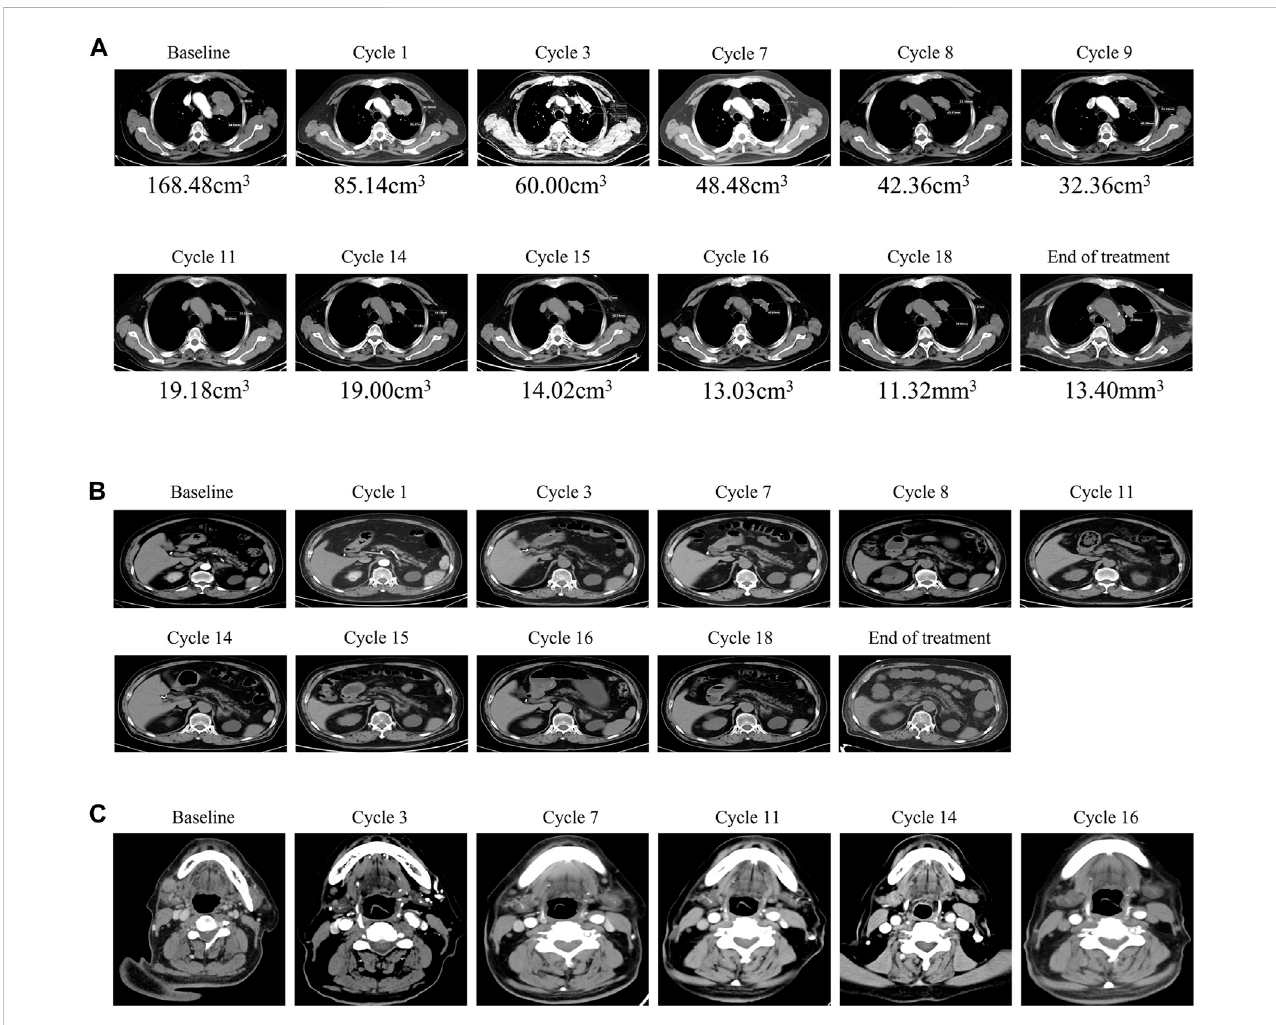
FIGURE 1 Changesinlungtumor andmetastatictumorduring camrelizumabandanlotinibtreatment. (A) CTshowedthat thelungtumorbegantoshrink after fi rst cycle of treatment until the end of treatment. (B) CT showed that the volume of bilateral adrenal invasion lesions was signi fi cantly reduced after fi rst cycle of treatment and disappeared after that. (C) CT showed that the volume of the right neck invasion lymph node lesion was signi fi cantly reduced to normal after three cycles until the end of